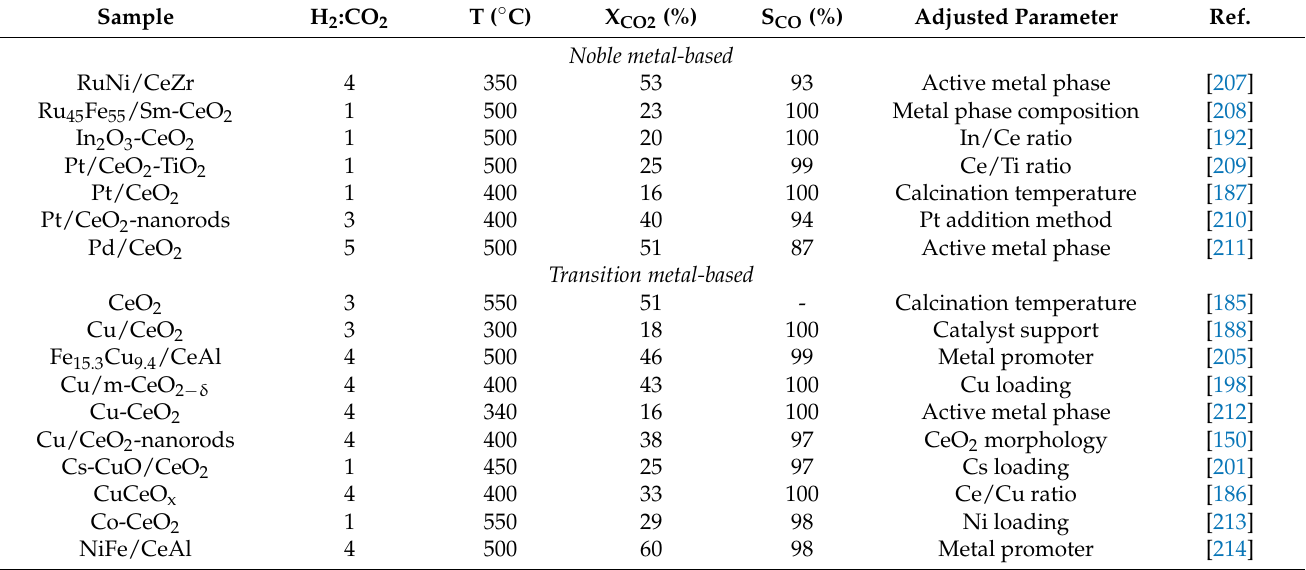
Table 1. State-of-the-art CeO 2 -based catalysts for the rWGS reaction at 1